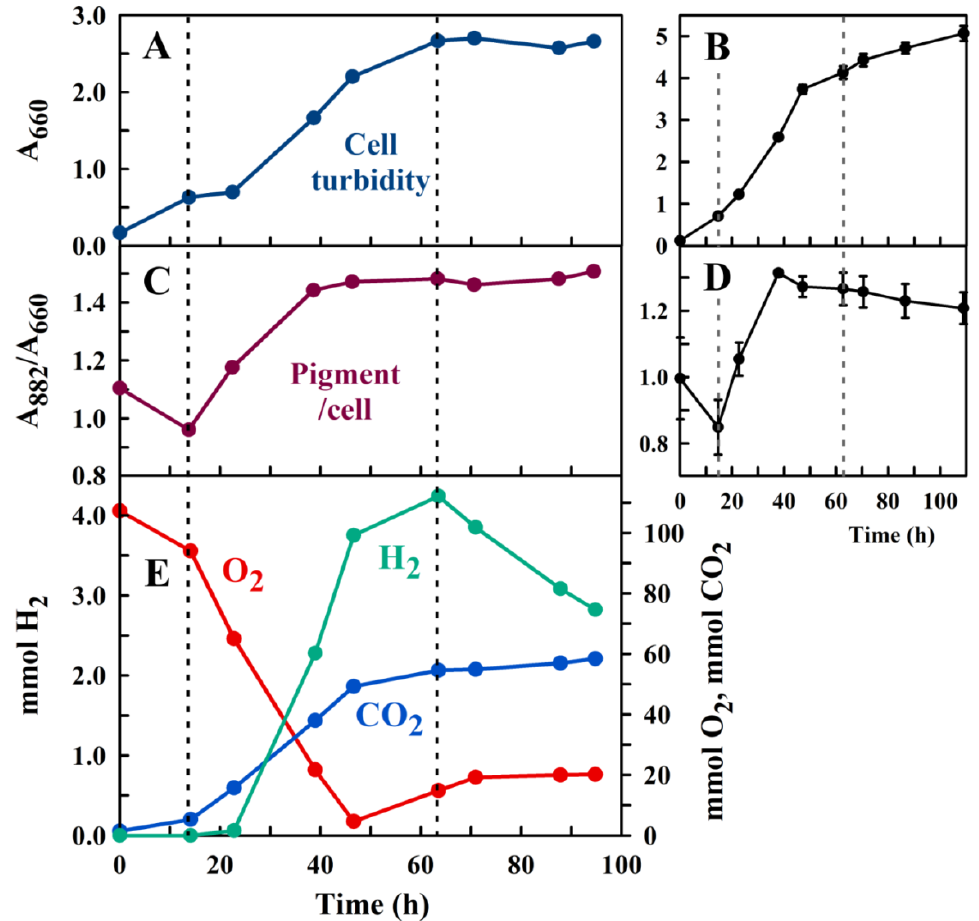
Figure 5. The R. rubrum growth experiment. ( A , B ) The absorption at 660 nm (A 660 , calculated for 1 cm path-length), reflecting cell growth of a single closed culture during the H 2 production experiment ( A ) and the averaged data of three independent (open) control cultures ( B ). ( C , D ) The ratio A 882 /A 660, reflecting the expression of photosynthetic membranes of a single closed culture ( C ) and the averaged data of three control cultures ( D ). The ( B , D ) panels (which show also the standard deviations of the measurements) have been included to show the reproducibility of the growth experiment. ( E ) GC measurements of gases in the total 12.5 litre gas reservoir of the closed hydrogen producing culture (see Section 4). The values shown are calculated amounts per litre culture. The first dashed line (at 13.8 h) shows the commencement of semi-aerobic growth, the second dashed line (at 63.3 h) indicates the establishment of the stationary growth phase (see main text).